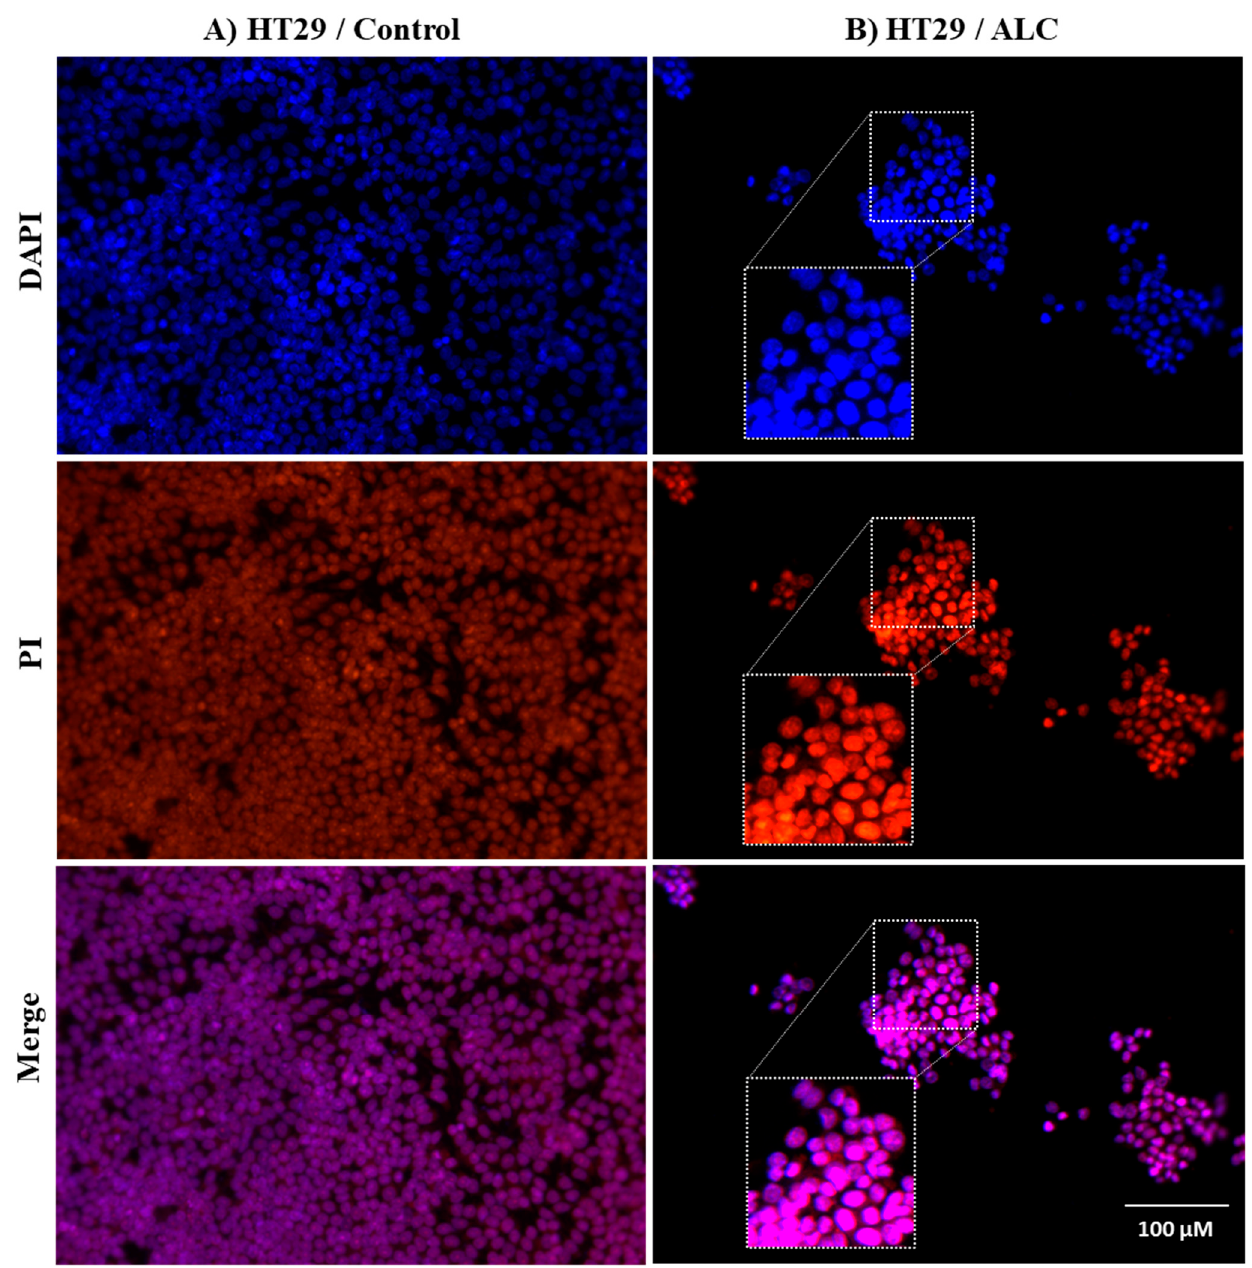
Figure 6. Fluorescent microscopy examination to evaluate apoptotic nucleus morphological changes in HT29 cells after ALC treatment compared to control. ( A ) control HT29 cell line, ( B ) ALC-treated HT29 cell line. HT29 cell lines were treated with their IC 50 concentration of ALC for 48 h and stained with DAPI and PI. Images were acquired under fluorescence microscopy with appropriate filters for PI and DAPI. ImageJ was used to overlay images. Rectangles show some cells after being magnified to illustrate the apoptotic effect of ALC on the nucleus.